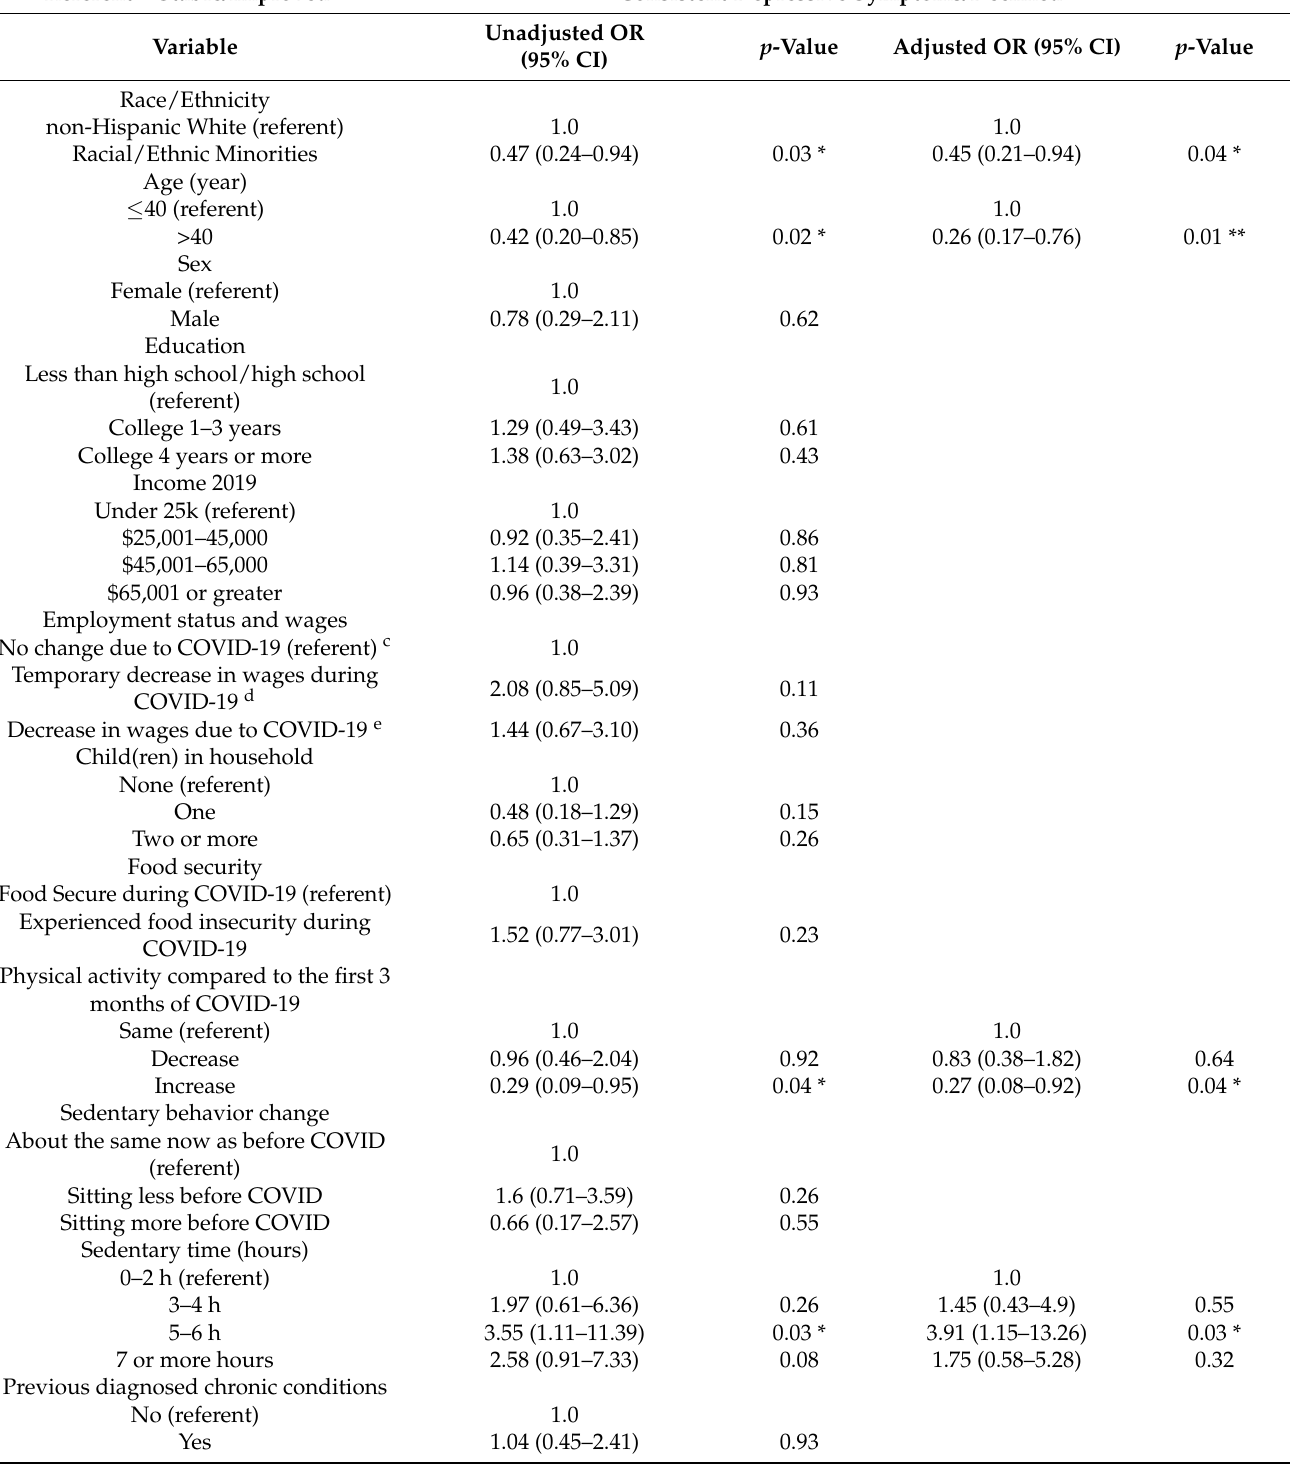
Table 2. Univariate and multivariable logistic regression of the correlates of depressive symptom occurrence patterns during COVID-19 pandemic among central Texas residents, FRESH-Austin Study, 2020 ( n =